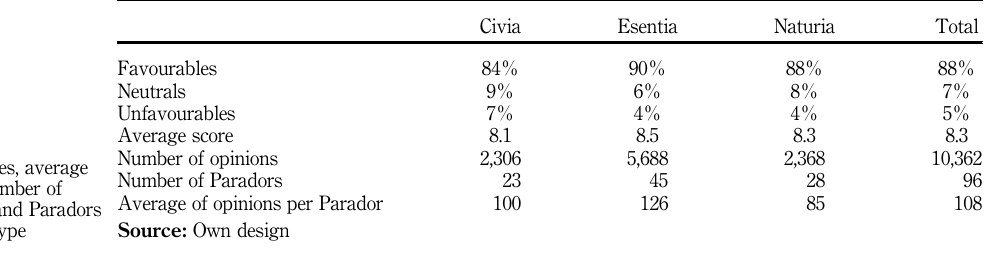
Table I. Frequencies, average scores, number of opinions and Paradors by hotel